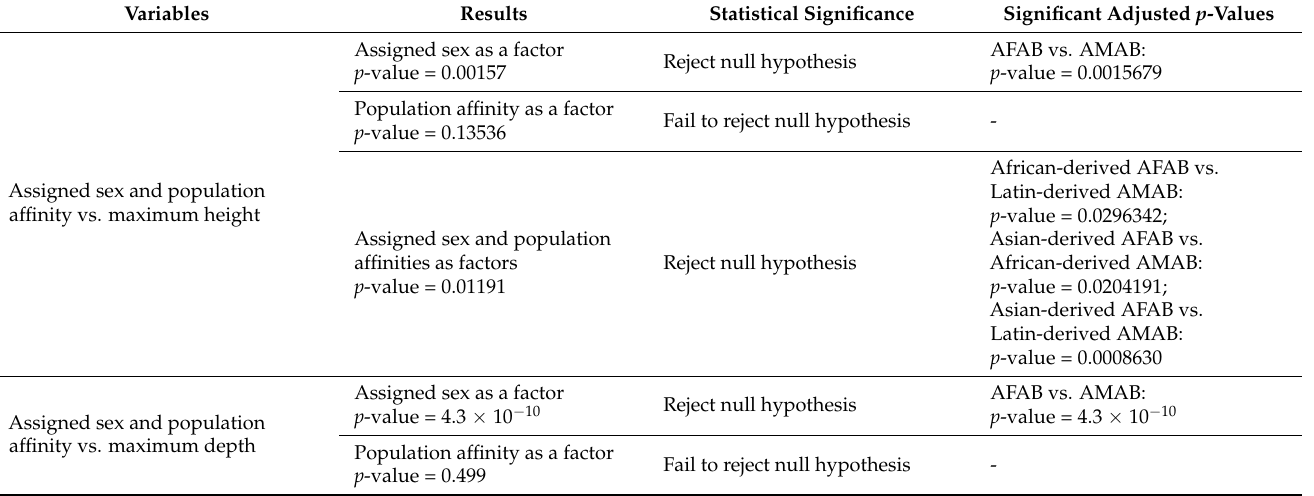
Table 4. Tukey post hoc tests of the statistically significant ANOVA